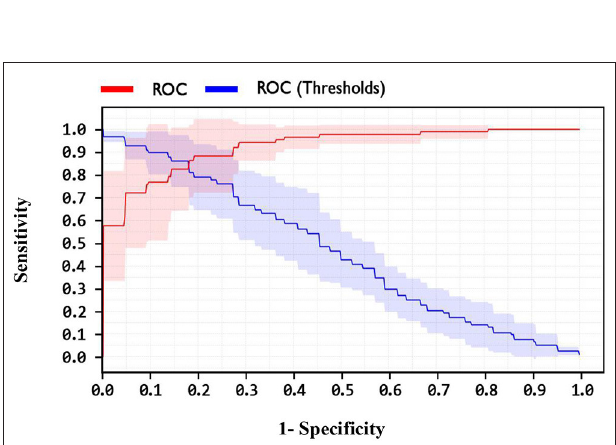
FIGURE 7 | Sensitivity diagram for GSVMA method for generation 10.